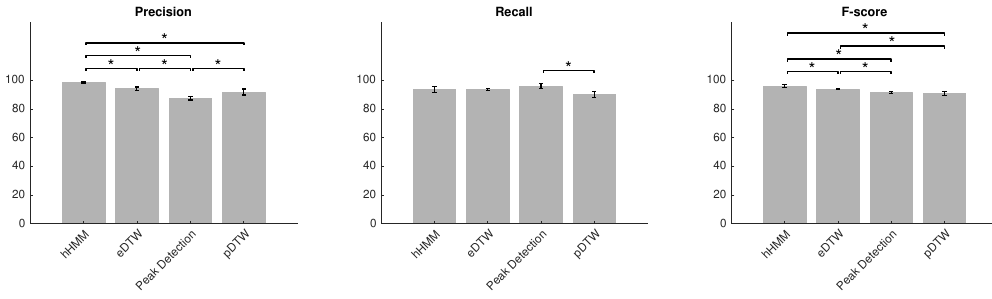
Figure 5. Mean ± STD of precision, recall and F-score for four methods. Asterisks represent a 5% significant difference between methods corresponding to 95% confidence